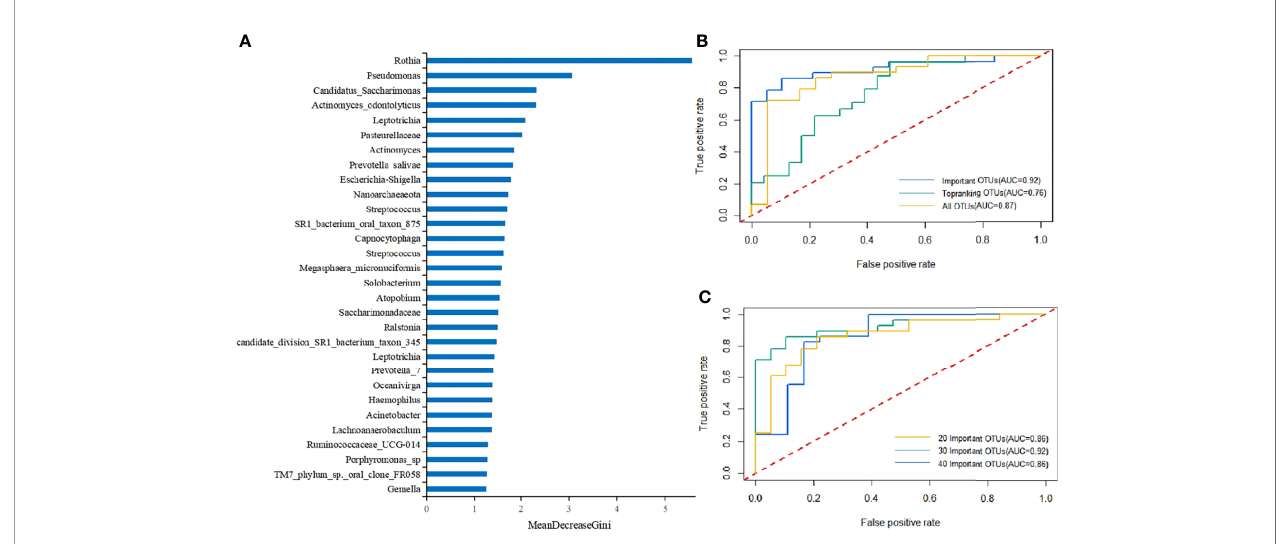
FIGURE 4 | (A) Key components of the RF model constructed using all OTUs to distinguish differences between T2DM patients and healthy controls (MeanDecreaseGini values represented the importance of species in the RF model). (B) The 10-fold cross-validation was performed on the RF model, and the model was reconstructed using the sample with the highest precision. The ROC curves and AUC values of the overall test set are shown above. The top 30 important and top-ranking OTUs were selected, respectively, where each OTU could be considered as an independent species. (C) The 10-fold cross-validation was performed on the RF model, and the model was reconstructed using the sample with the highest accuracy. The ROC curves and AUC values of the overall test set are shown above. 20 Important OTUs, 30 Important OTUs, and 40 Important OTUs represented the top 20, 30, and 40 OTUs in importance, respectively, where each OTU could be considered as an independent species.